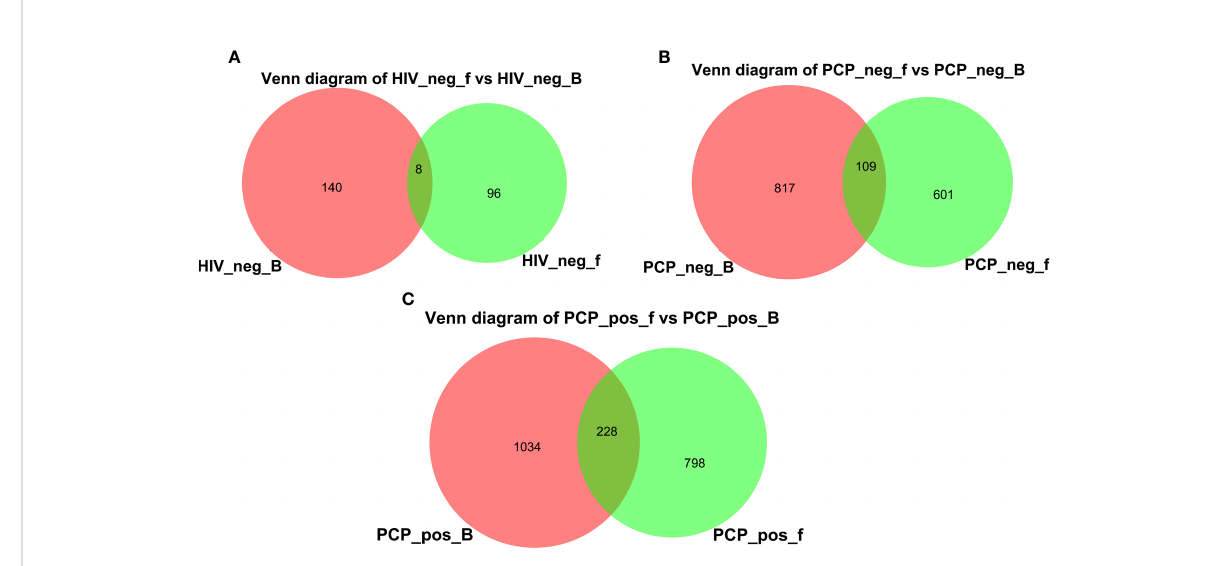
FIGURE 12 Venn diagram of lung and gut microbiomes. (A) Venn diagram of lung and gut microbiomes in HIV- patients. (B) Venn diagram of lung and gut microbiomes in HIV+PCP- patients. (C) Venn diagram of lung and gut microbiomes in HIV+PCP+ patients. HIV_neg_B: lung microbiomes of HIV- group; HIV_neg_f: gut microbiomes of HIV- group; PCP_neg_B: lung microbiomes of HIV+PCP- group; PCP_neg_f: gut microbiomes of HIV+PCP- group; PCP_pos_B: lung microbiomes of HIV+PCP+ group; PCP_pos_f: gut microbiomes of HIV+PCP+